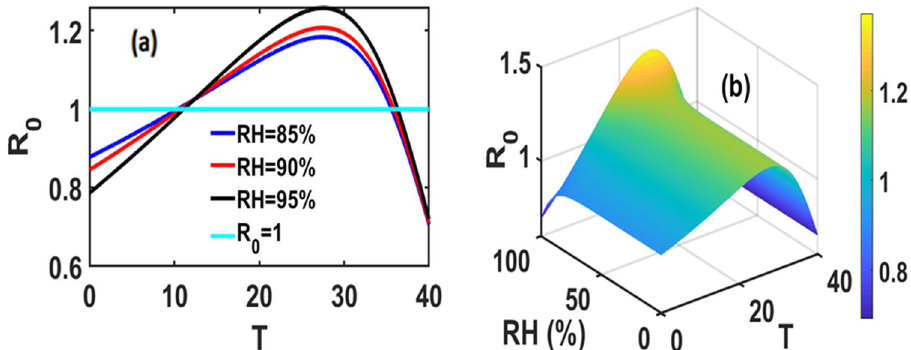
Figure 1. Combined effect of Temperature (T) and Relative Humidity (RH) on basic reproduction number ( R 0 ) expression. ( a ) Dependence of R 0 on temperature at constant RH and ( b ) 3D plot of R 0 as a function of both RH and temperature.